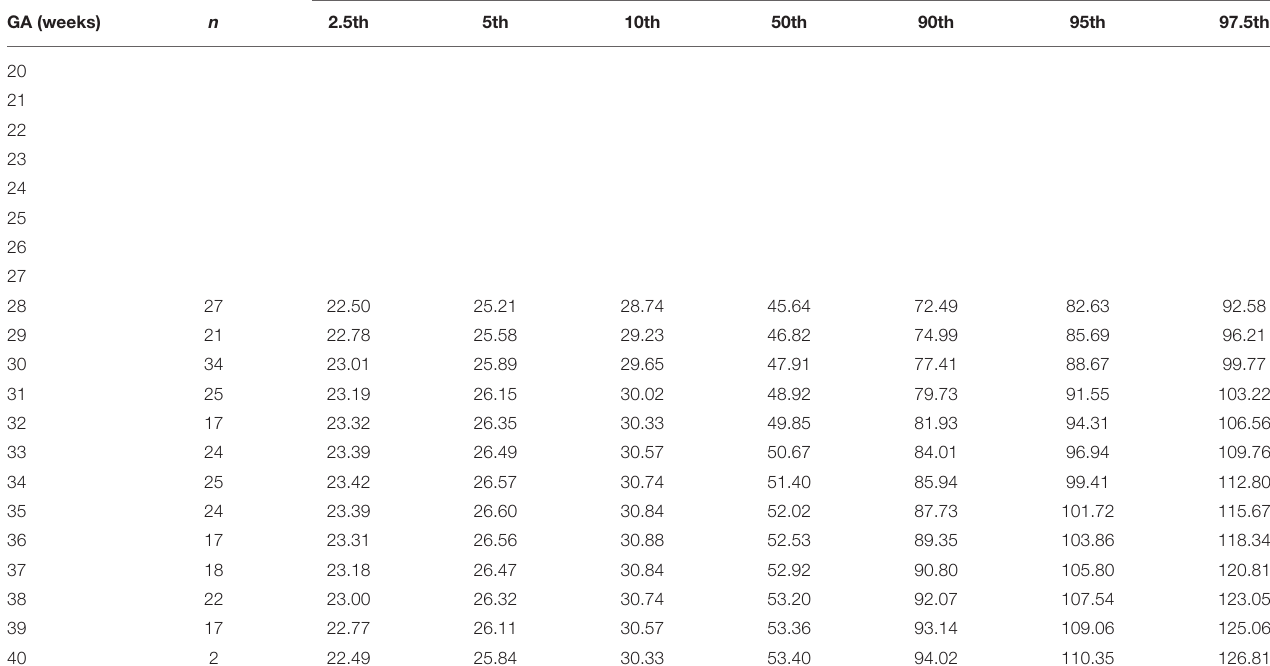
TABLE 6 | Percentiles of fetal superior vena cava volume blood flow normalized by brain weight (ml/min/100g) at 28–40 weeks of gestational age (GA).